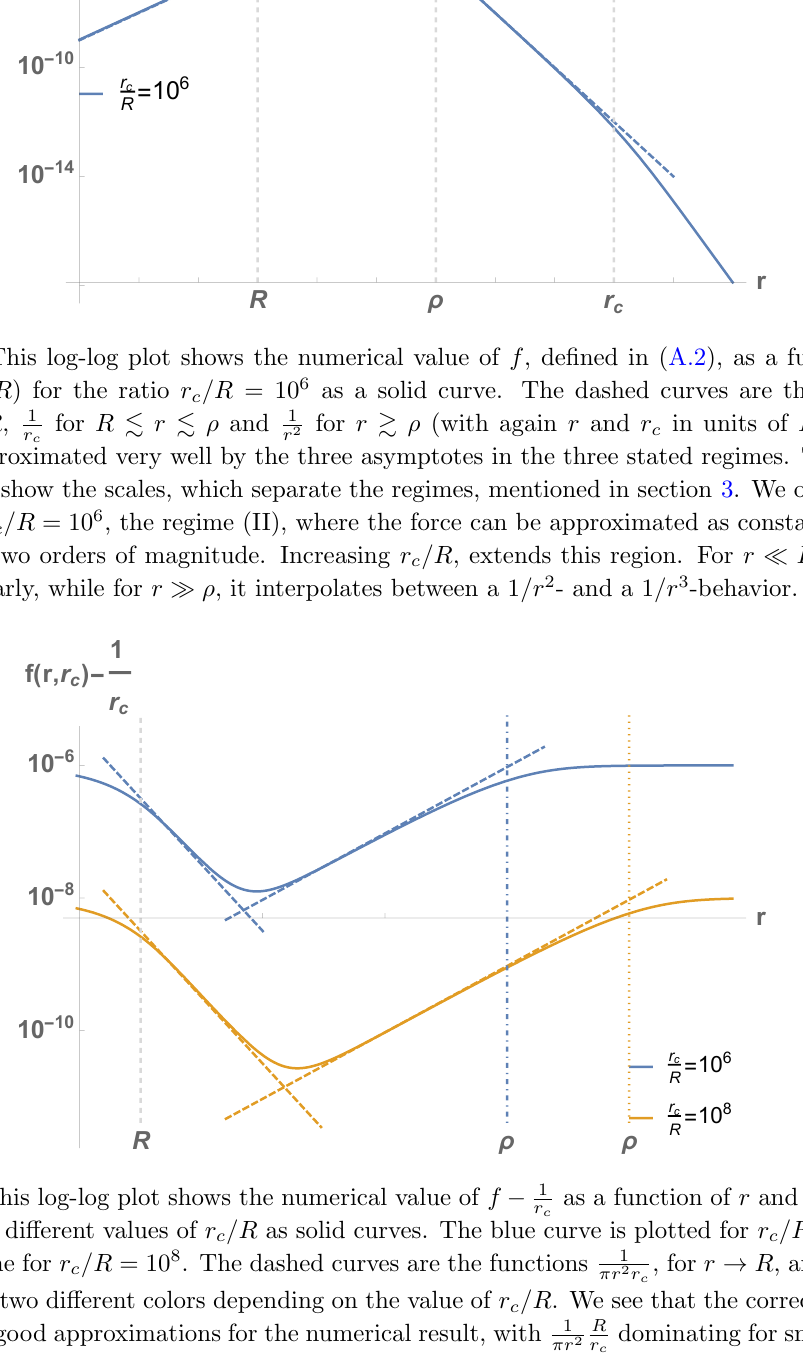
as a function of r and r c (in units r c p 2 r , for r ! R , and 2 , (cid:25)r 2 r c 3 r 3 = 2 c R dominating for smaller r and (cid:25)r 2 r c